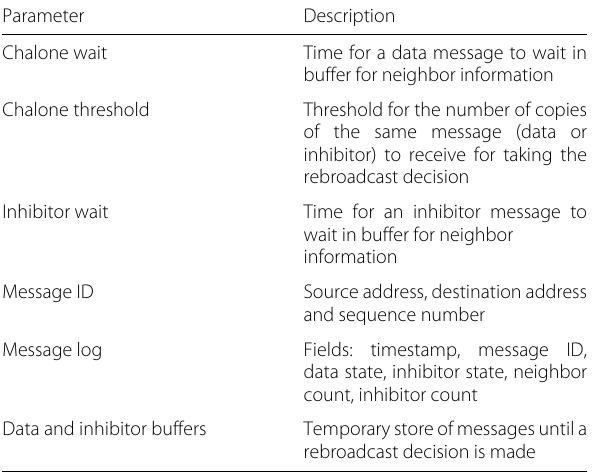
Table 5 Summary of parameters in proposed Endcast